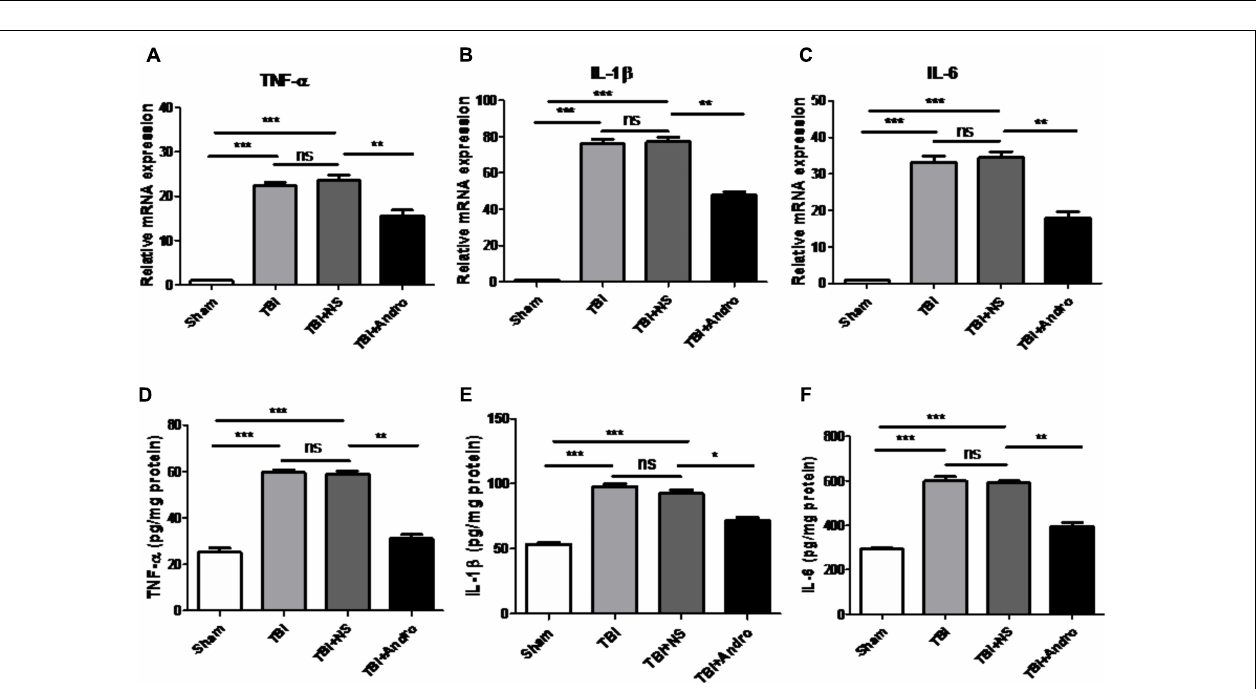
FIGURE 4 | Andro treatment decreased the expression levels of pro-inflammatory cytokines after TBI. The mRNA levels of TNF- α (A) , IL-1 β (B) and IL-6 (C) in peri-contusive cortex were determined by QPCR at 6 h after TBI. The protein levels of TNF- α (D) , IL-1 β (E) and IL-6 (F) in peri-contusive cortex were measured by ELISA at 24 h after TBI. All data are presented as the mean ± SD. ∗ p < 0.05, ∗∗ p < 0.01 ∗∗∗ p < 0.001, ns p > 0.05; n = 6 in each group.